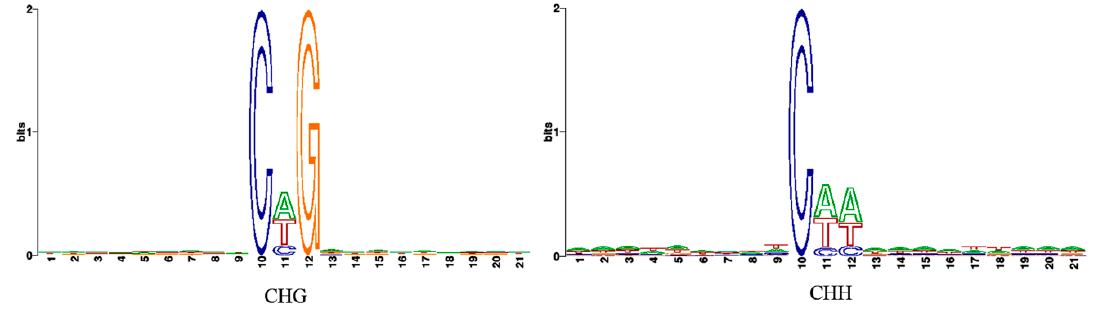
Figure 4. Sequence characteristic analysis of nine bp bases neighbouring methylated CHG and CHH. The x -axis represents the nine bp upstream and downstream of CHG and CHH, the height of the y -axis is the maximum entropy for the given sequence type (A, T, C, and G).